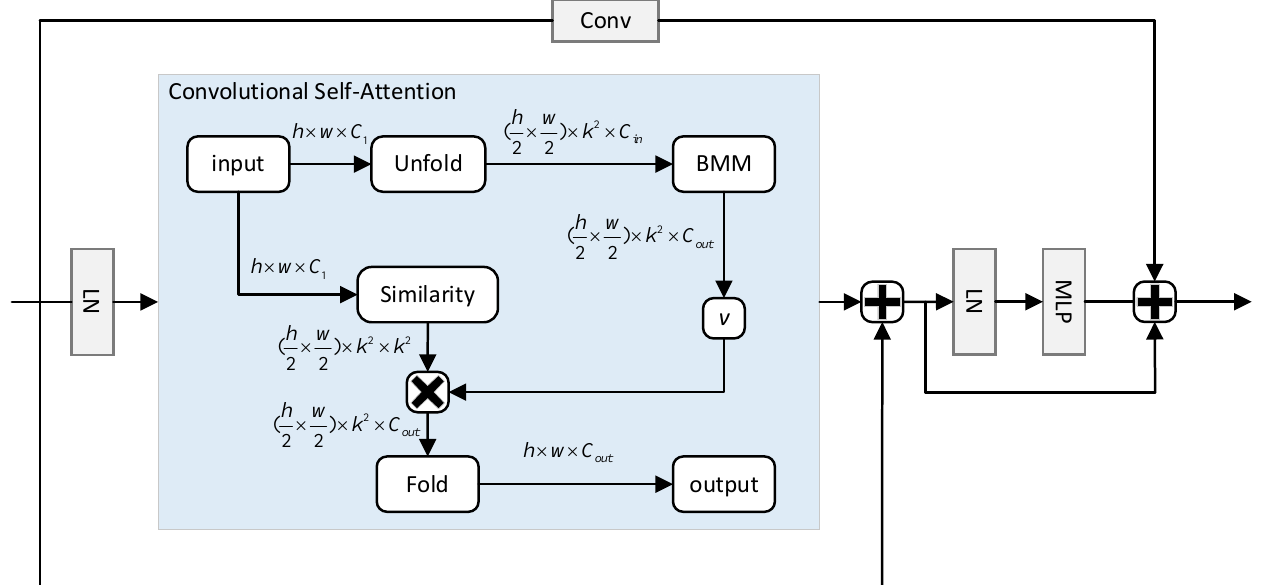
Figure 4. Convolutional self-attention module.